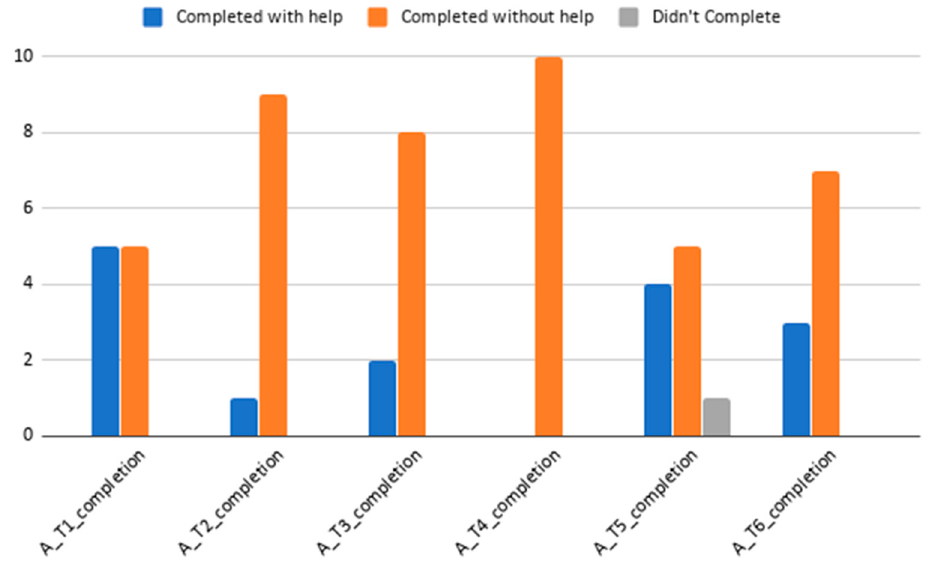
Figure 11. Task completion results. Bar chart plot showing task completion results and if help was required for task completion.